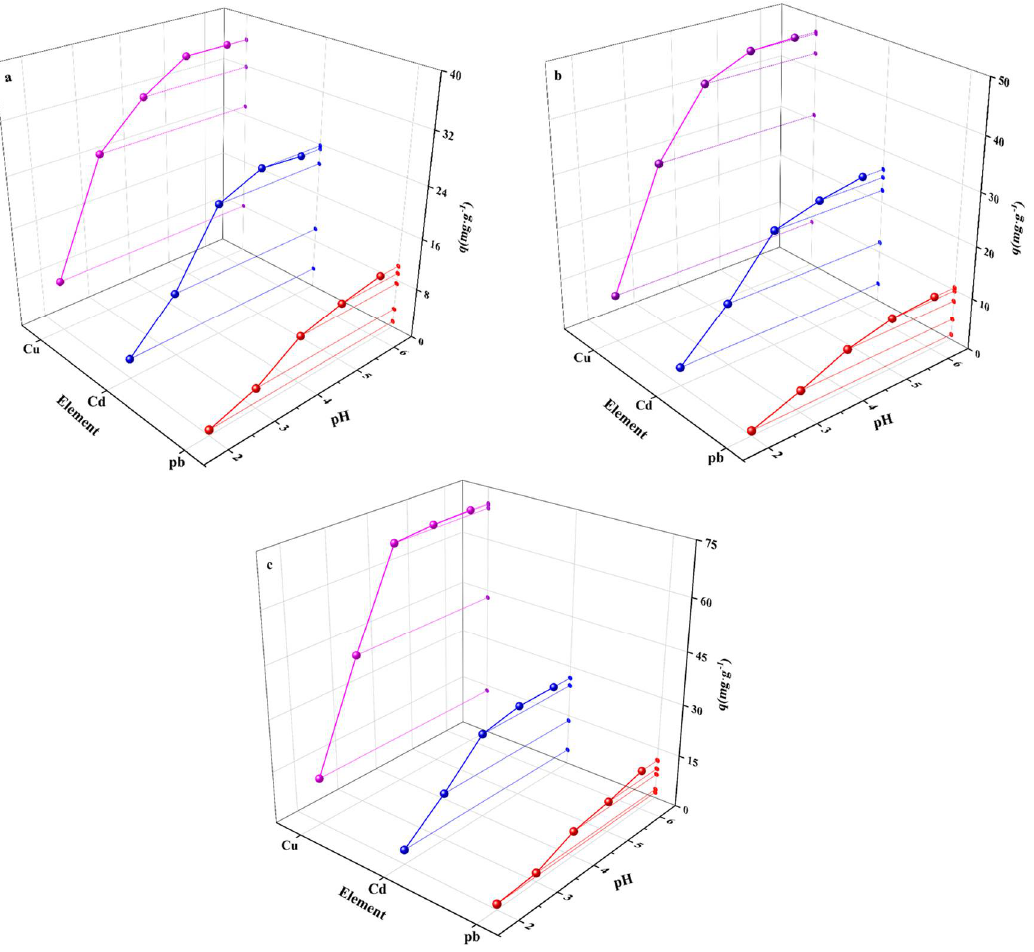
Figure 1. The effect of initial solution pH on the adsorption of heavy metals by BC ( a ), chitosan- modified biochar ( b ) and GBC ( c ). Table 1. Distribution coefficient and selectivity coefficient of competitive adsorption of Pb, Cd, and Cu on